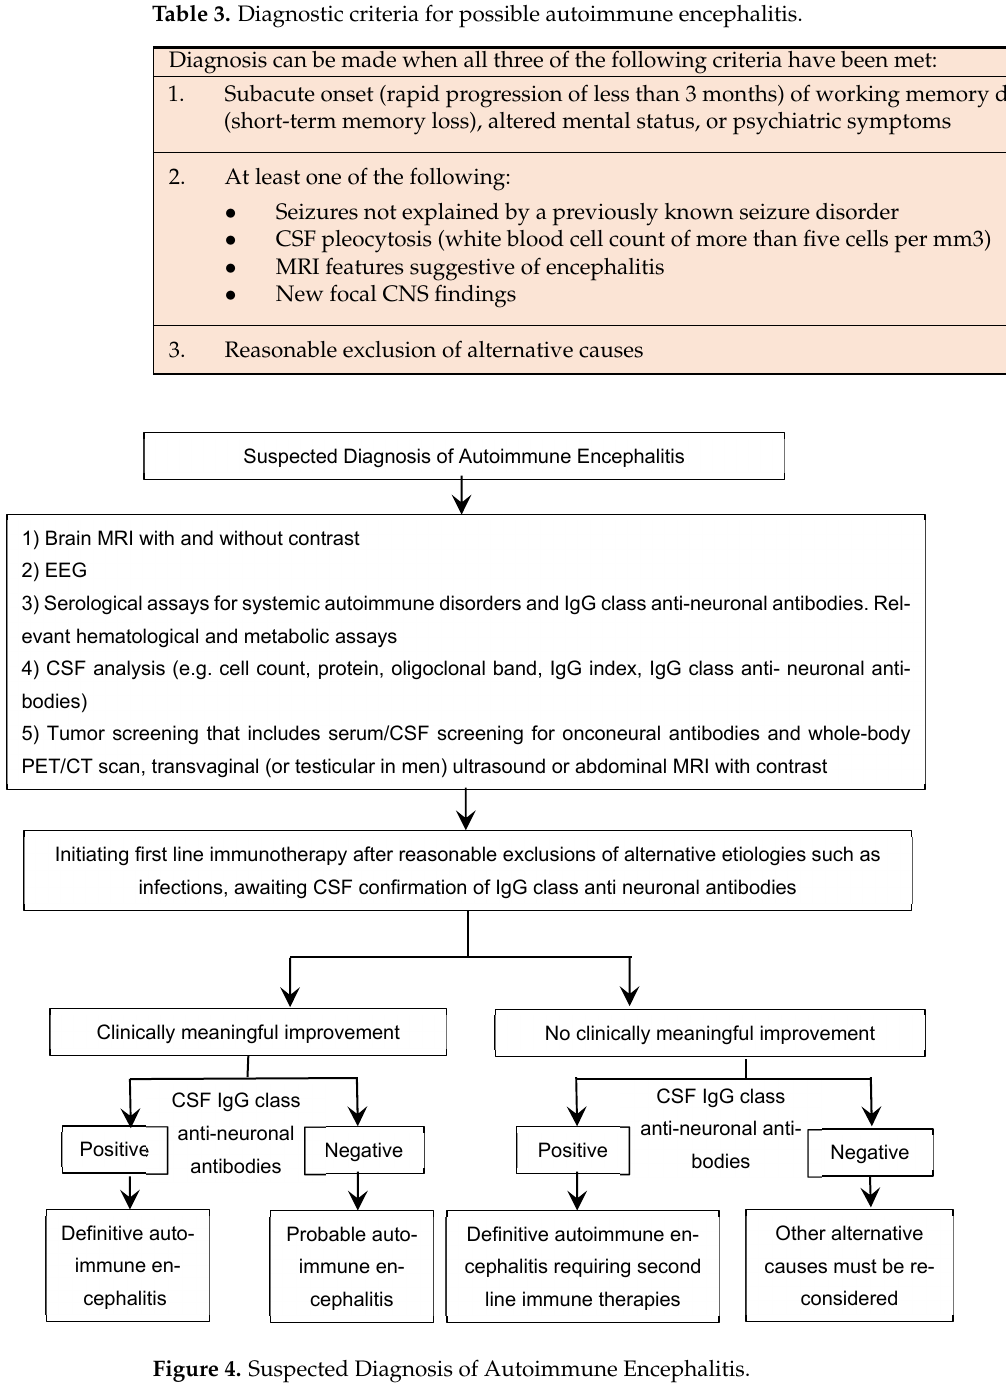
Figure 4. Suspected Diagnosis of Autoimmune